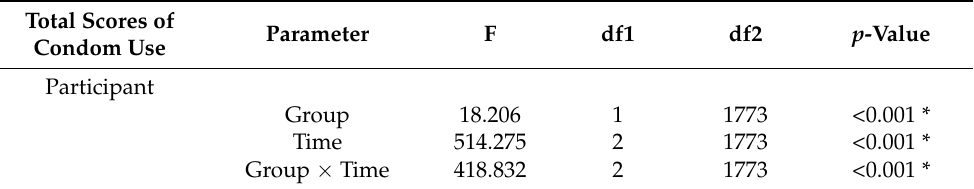
Table 4. Fixed effects of group, time, and group–time interaction on total condom use frequency scores (ITT).